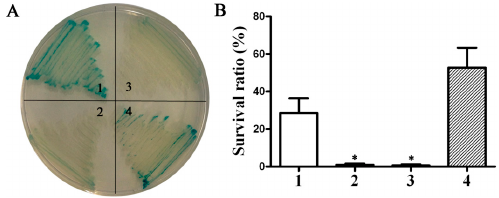
Figure 1. Identification of the phoP gene of P. multocida . ( A ) Detection of phosphatase activity. Four S. Typhimurium strains, S184 ( Δ asd ) harboring empty plasmid pQK664, S412 ( Δ asd Δ phoP ) harboring pQK664, S412 harboring pQK167 and S412 harboring pQK168, were cultured on X-P plates supplemented with 50 µ g/mL diaminopimelic acid (DAP), and the colony colors were observed; ( B ) The resistance to polymyxin B. The four strains described in A were cultured in Luria-Bertani (LB) broth with or without 0.1 µ g/mL polymyxin B for 1 h, and then the survival ratio of each strain was calculated. 1, 2, 3 and 4 refer to S184 (pQK664), S412 (pQK664), S412 (pQK167) and S412 (pQK168), respectively. The data in B are expressed as the mean value ˘ standard deviation (SD) and were analyzed with the significance level set at 0.05 (*) compared to the S184 strain.